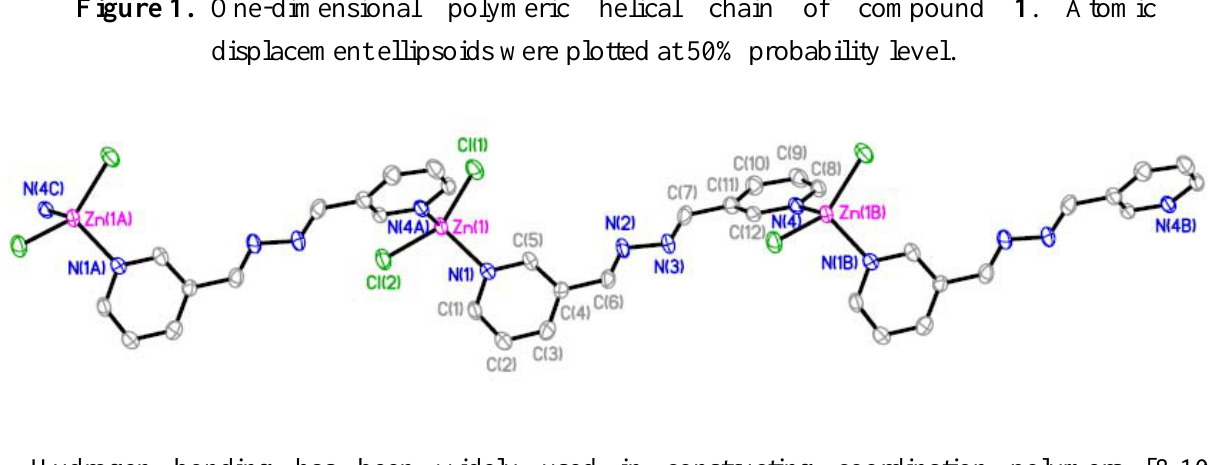
Figure 1. One-dimensional polymeric helical chain of compound 1 . Atomic displacement ellipsoids were plotted at 50% probability